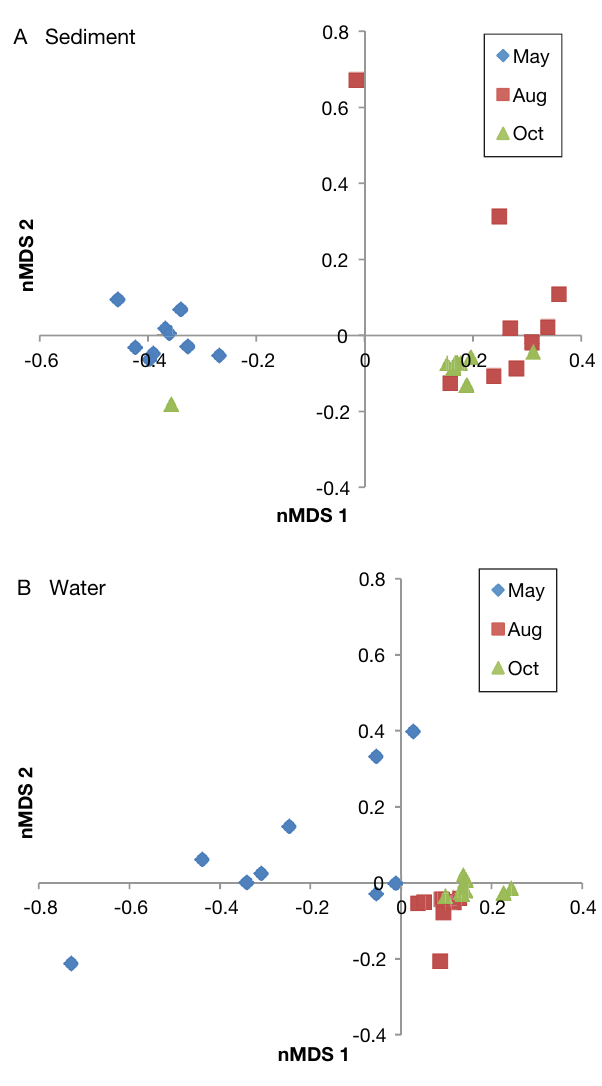
Fig. 3. Non-metric multidimensional scaling (nMDS) ordina- tion of Bayesian distances among all (A) sediment and (B) water samples. Samples from May showed significant sepa- ration from August and October (PERMANOVA, p < 0.01)